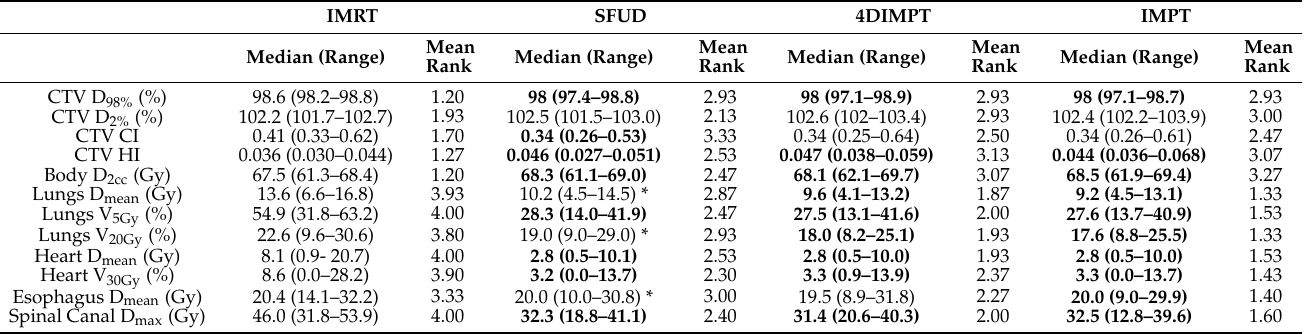
Table 1. Dose-volume parameters for the target, patient body, and OARs for the different optimization techniques, evaluated on the planning scan. The mean rank (obtained by Friedman’s test) for each technique regarding each evaluated parameter is also shown. A mean rank of 1 would mean that this was the best plan for all patients, while a mean rank of 4 means that this was the worst plan for all patients. Statistically significant differences ( p < 0.05) compared to the IMRT plan are shown in bold. IMRT SFUD 4DIMPT IMPT Median (Range) Mean Rank Median (Range) Mean Rank Median (Range) Mean Rank Median (Range) Mean